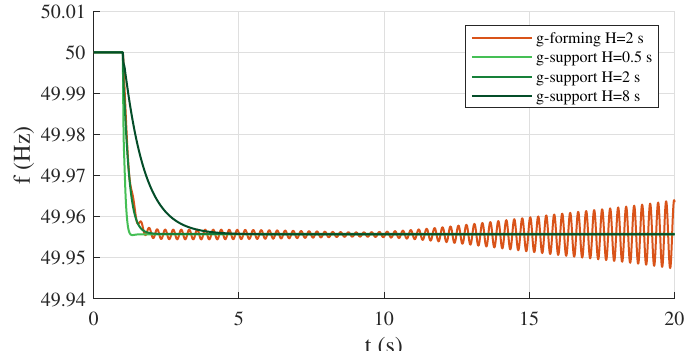
Figure 14. Contribution of grid-supporting controls with many grid-forming